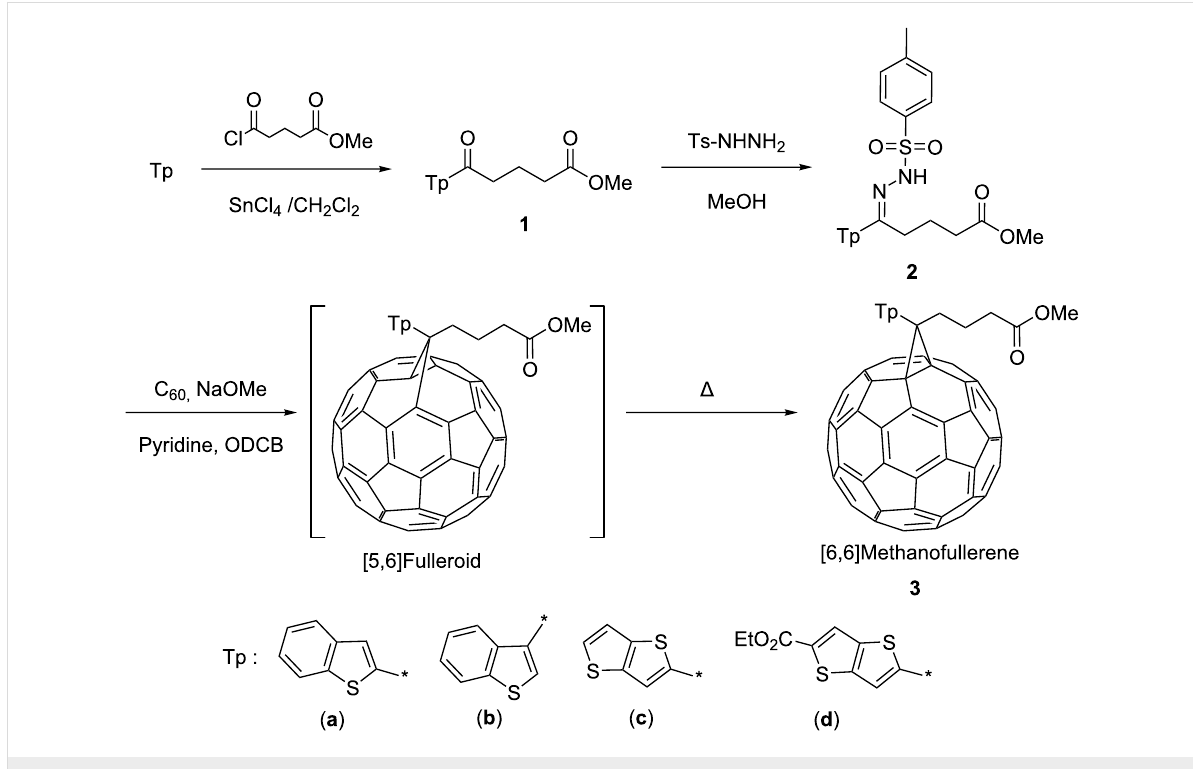
Scheme 1: Synthesis of methanofullerenes ( 3a – d